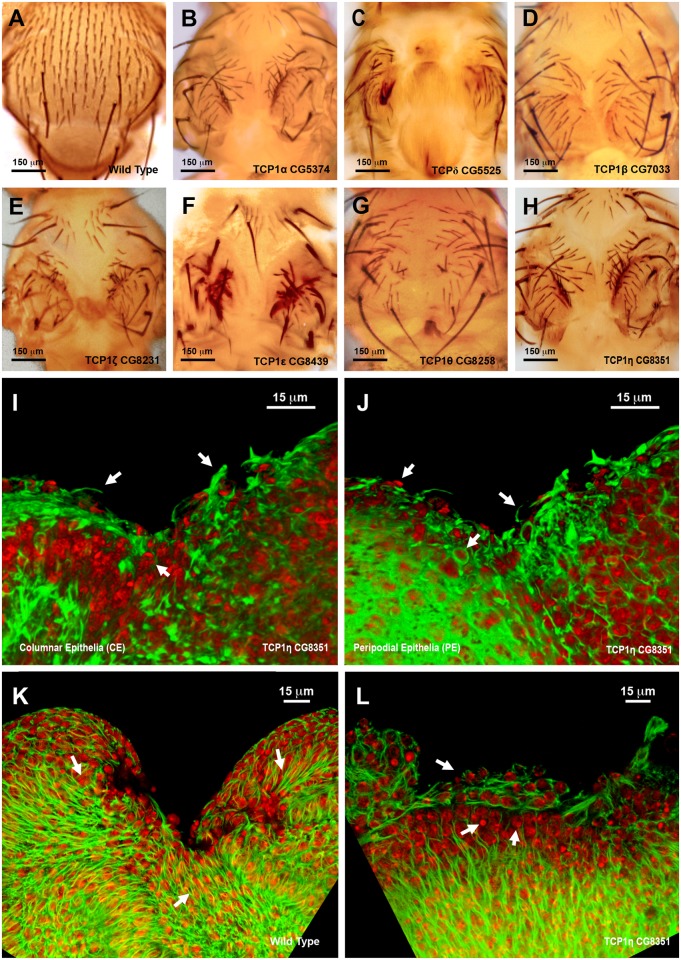
Thorax fusion and impaired healing phenotypes of TCP1 subunits.
A) Wild type notum of an adult Drosophila. B to H) Thorax malformations observed after interference (RNAi) with the expression of different TCP1 subunits as labeled (tested with a Pnr-GAL4 driver). I and J) 3D reconstruction of the peripodial and columnar epithelia at 18 hours after wounding. (I) PE and (J) CE views. TCP1η RNAi knockdown results in impaired healing after 20–24 hours of culture in vitro (tested with a En-GAL4 driver). Arrows point to abnormal actin-rich structures and arrowheads to dead cells. Phalloidin (actin) is shown in green; DAPI (nuclei) in red. K) Injured wild type disc after 12 hours of in vitro culture. CE view showing the perpendicular alignment of microtubules to the sealing front (arrows) and elongated cells at the leading edge. A remarkable reduction in wound size is observed. L) Injured TCP1η RNAi knockdown disc after 12 hours of culture in vitro. CE view showing conspicuous picnotic nuclei (arrowheads) and an abnormal transverse alignment of microtubules (arrows) at the leading healing front. Wound closure fails to proceed. Tubulin is shown in green; DAPI (nuclei) in red. Scale bars are indicated for each panel.